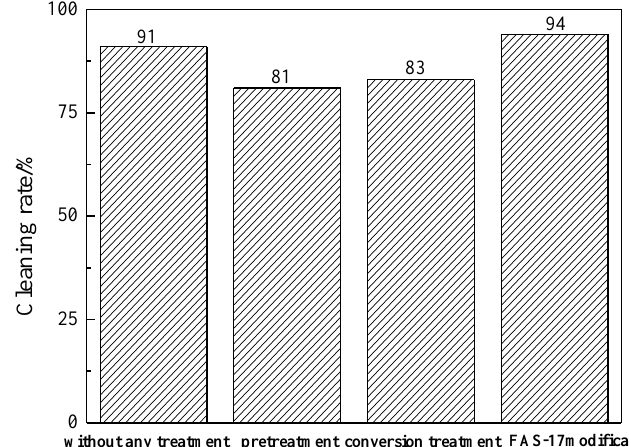
Figure 8. The cleaning rate of 5052 aluminum alloy samples under different treatments.